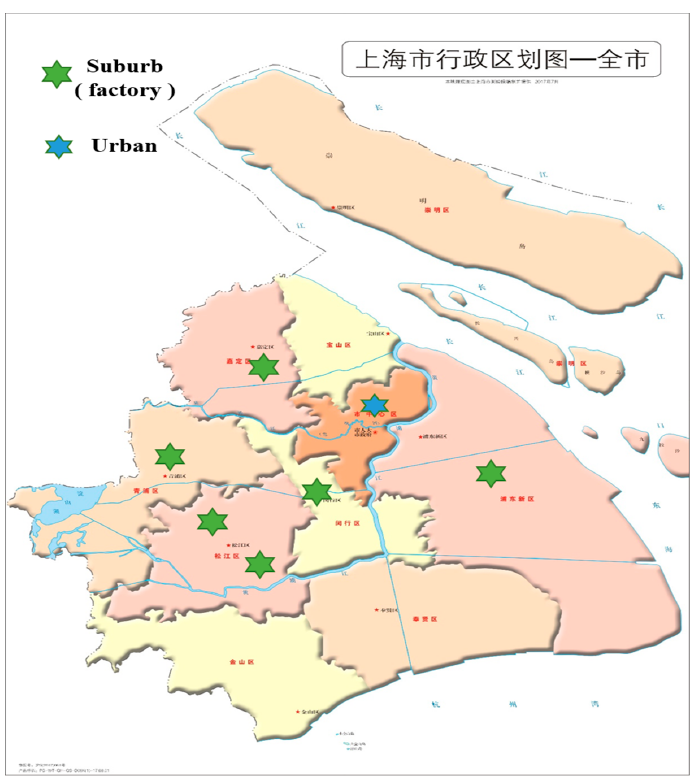
Figure 1. The distribution of sampling sites.